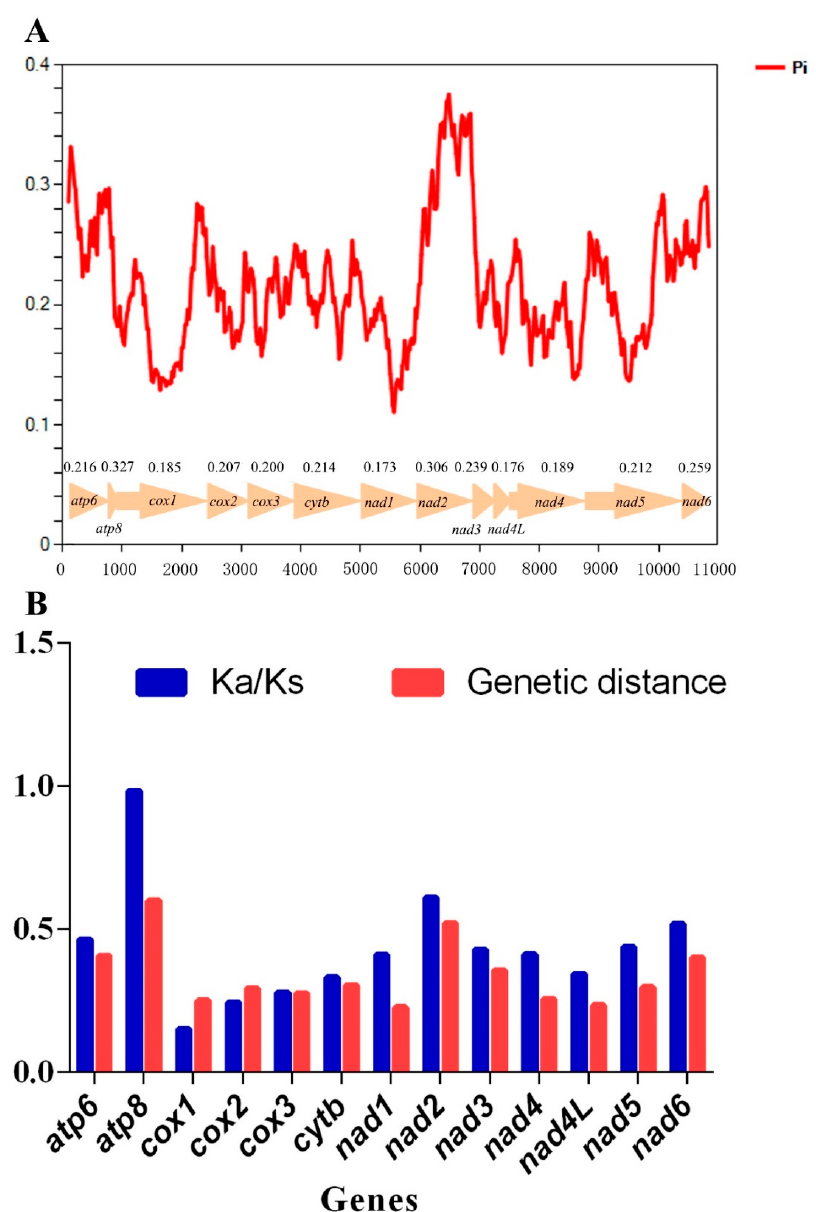
Figure 5. Nucleotide diversities and selection pressures of 13 protein coding genes (PCGs) in Hylicinae. ( A ) Sliding window analysis of protein-coding genes among four Hylicinae species. The red curve shows the value of Pi (nucleotide diversity). Pi value of each PCG is shown above the arrows. ( B ) Genetic distances (on average) and ratio of non-synonymous (Ka) to synonymous (Ks) substitution rates of each protein-coding gene among four Hylicinae